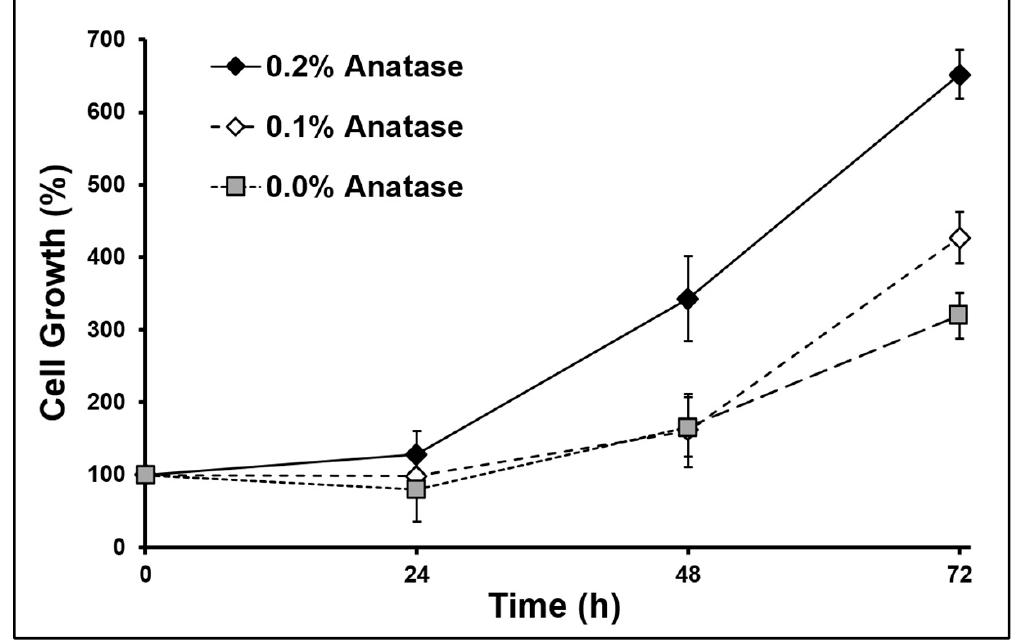
ff olds at 1 × 10 4 cell / cm 2